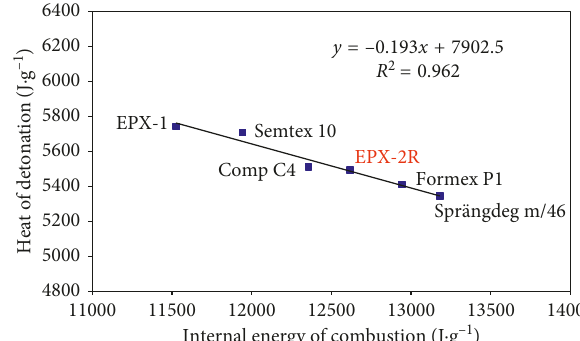
Figure 5: Inversely proportional relationship between the mea- sured internal energy of combustion and the calculated heat of